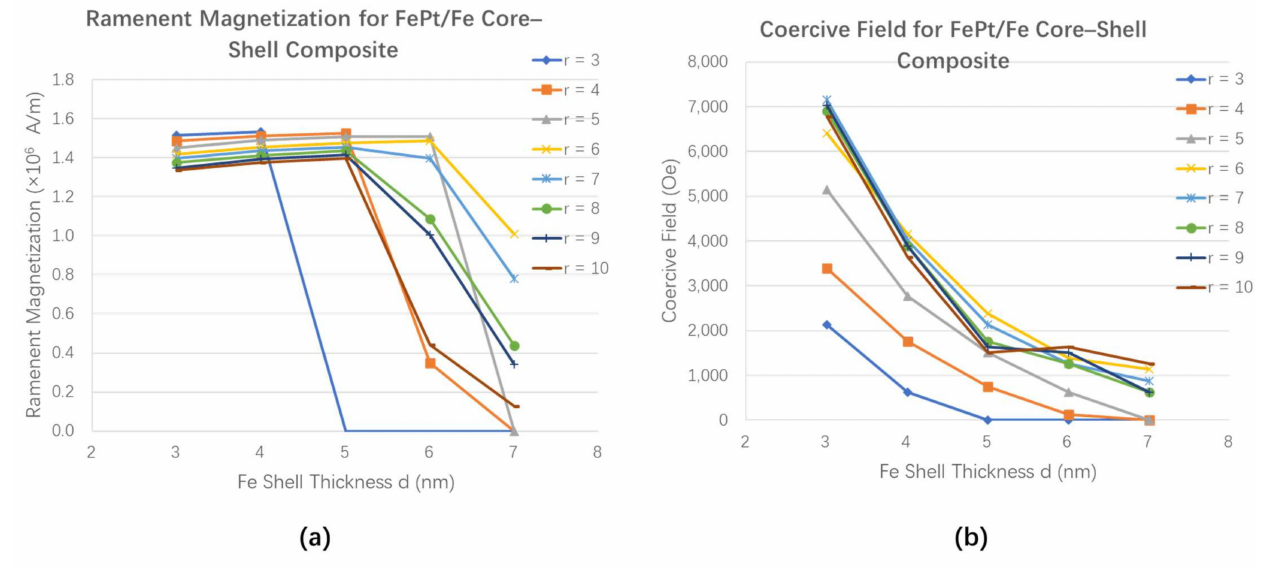
Figure 4. The magnetic properties as a function of the thickness of the iron shelland the radius of FePt core. ( a ) The remanent magnetization ( b ) the coercivities. In this figure, r is the radius of FePt